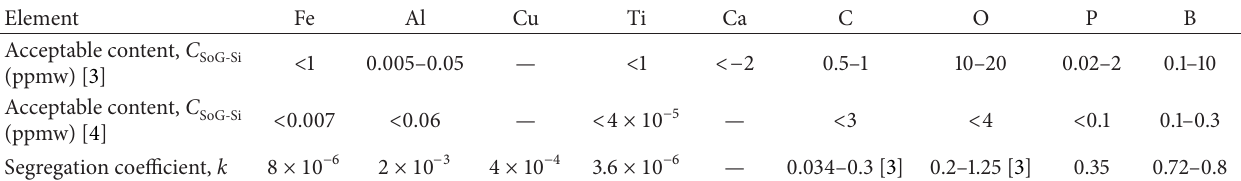
) and their equilibrium segregation coefficients ( k ). SoG-Si